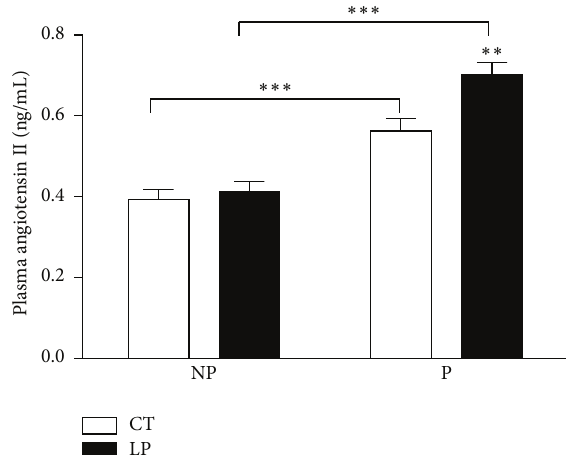
Figure 6: Plasma levels of angiotensin II in nonpregnant and pregnant rats fed a low-protein diet. CT: control; LP: low protein; NP: nonpregnant rats fed either CT or LP diet for 17 days; P: pregnant rats fed either CT or LP diet for 17 days. The error bar represents the mean ± SEM ( 𝑛 = 5 - 6 rats/diet group/day). ∗∗ 𝑃 < 0.01 ; ∗∗∗ 𝑃 < 0.001 .